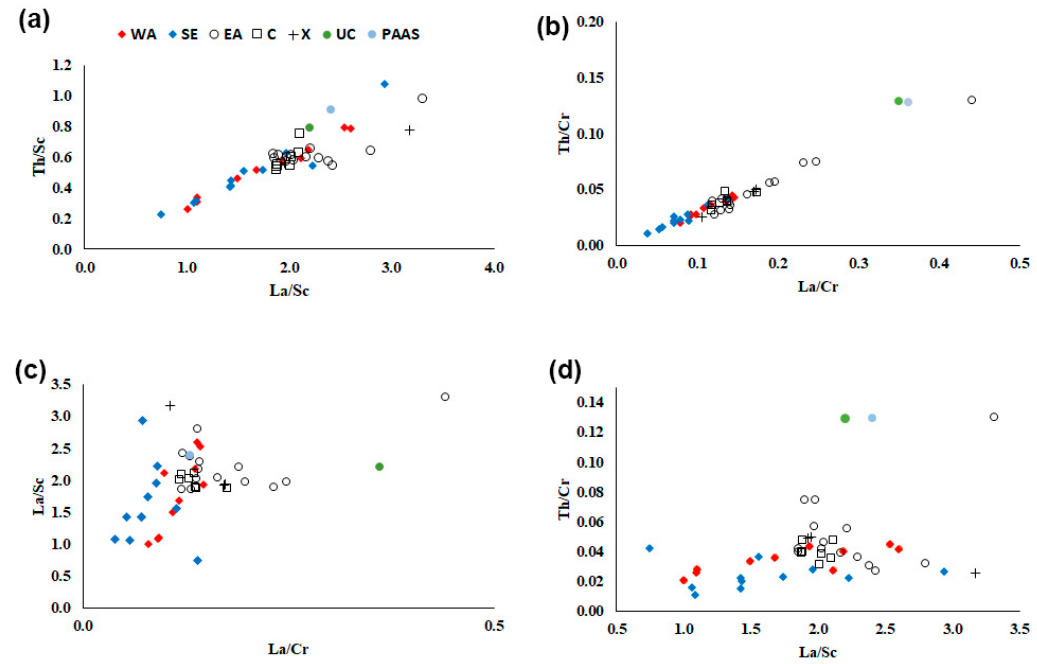
Figure 8. Plots of the elemental ratios ( a ) Th/Sc-La/Sc; ( b ) Th/Cr-La/Cr; ( c ) La/Sc-La/Cr; and ( d ) Th/Cr-La/Sc. The data of EA, X, and C are published elsewhere [12].